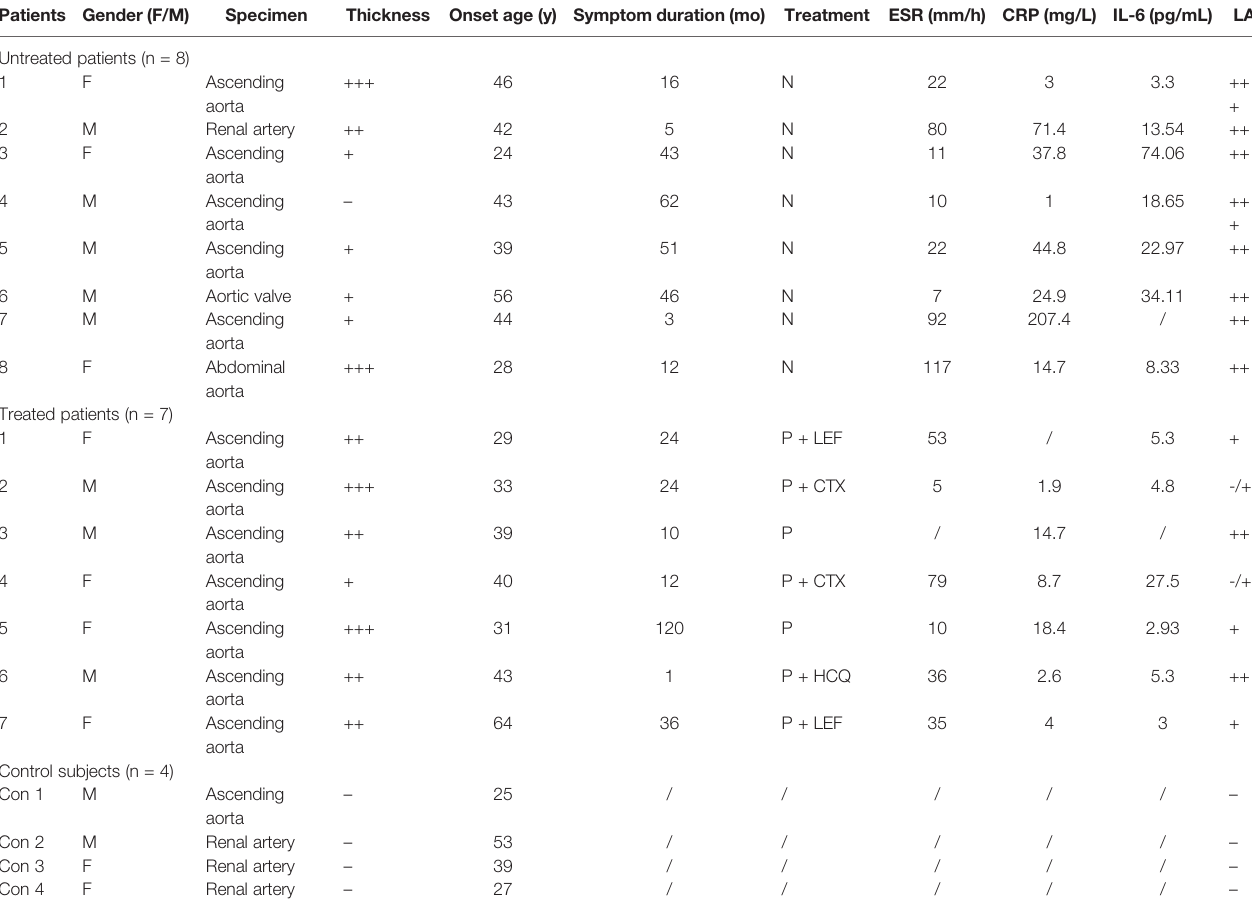
TABLE 1 | Clinical characteristics of the patients enrolled for vascular tissue examination. Patients Gender (F/M)